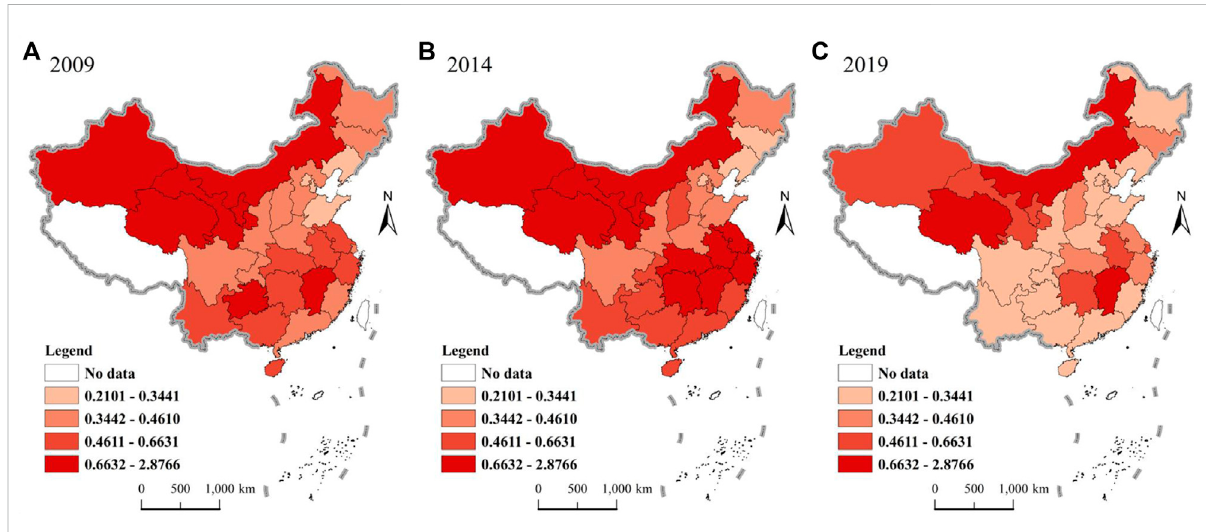
FIGURE 2 The spatial and temporal patterns of China ’ s agricultural carbon emission intensity in 2009, 2014, and 2019.